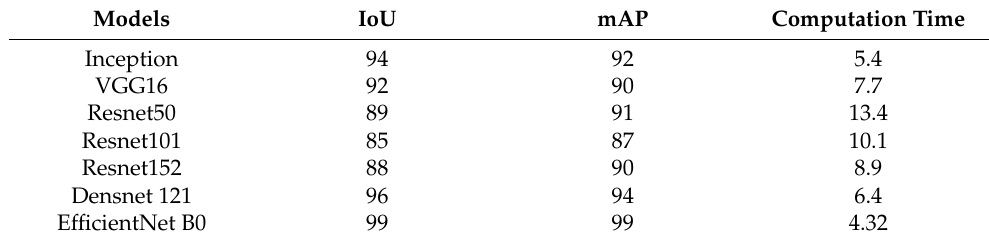
Figure 9. Models vs. ( a ) IoU, ( b ) mAP, ( c ) CT.